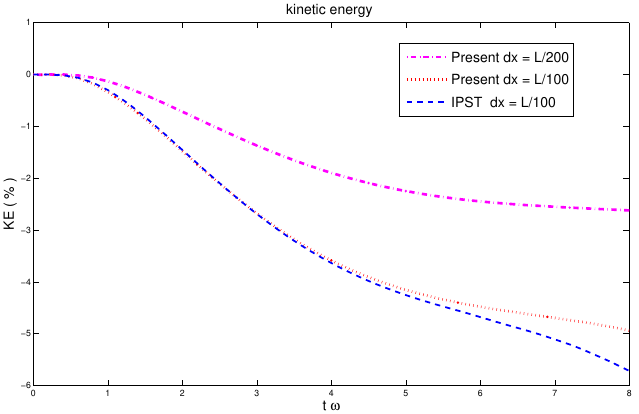
Figure 20. Evolution of an initially-square fluid patch: Dissipation of the kinetic energy. The red dotted line presents the results obtained by the present particle shifting formulation for the particle resolution of dx = L , The blue dashed line represents the results obtained by using IPST [37] for the particle 100 resolution of dx = L . whereas for the magenta dash-dot line presents the results obtained by the 100 present particle shifting formulation for the particle resolution of dx = L